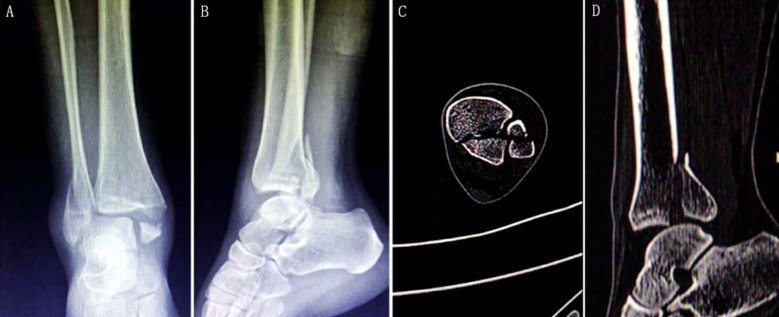
Imaging results a 47-year-old female patient who suffered from 3.5 h of car accident-induced right ankle swelling and pain complicated with limitation of motion before surgery. A: Frontal X-ray film of ankle joint; B: lateral X-ray film; C: CT scan cross-section image; D: CT scan sagittal image.